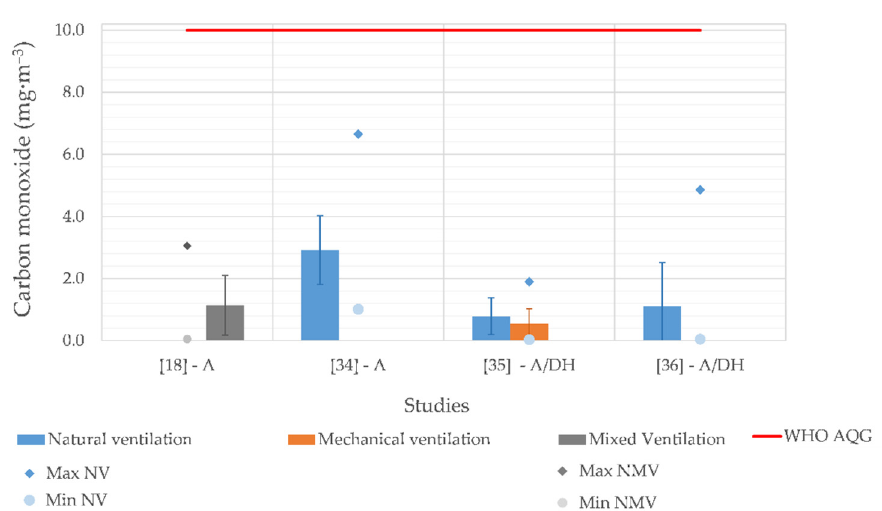
Figure 5. Carbon monoxide levels monitored during the sleeping period at bedrooms in different types of building (A—apartment; A/DH—mixed (apartment and detached house); DH—detached house) and different types of ventilation settings (NV—natural; mechanical—MV; mixed—NMV). Bars provide mean values (along with standard deviation when available). WHO AQG stands for the air quality guideline value recommended by WHO [41], and max and min stand for maximum and minimum values, respectively.